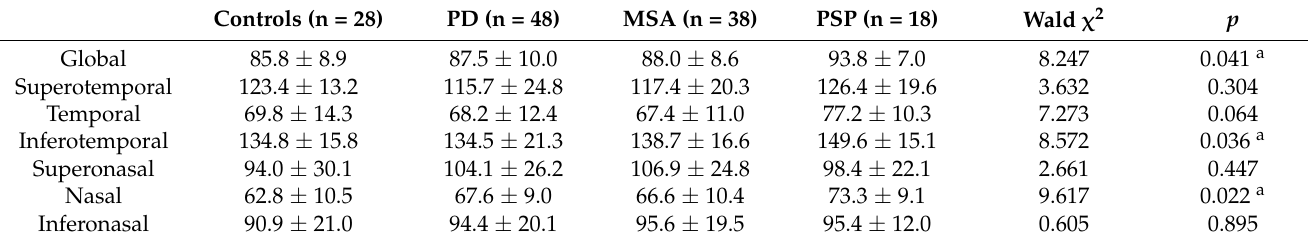
Table 3. Comparisons of peripapillary retinal nerve fiber layer thickness ( µ m) between different groups (4.1 mm diameter).